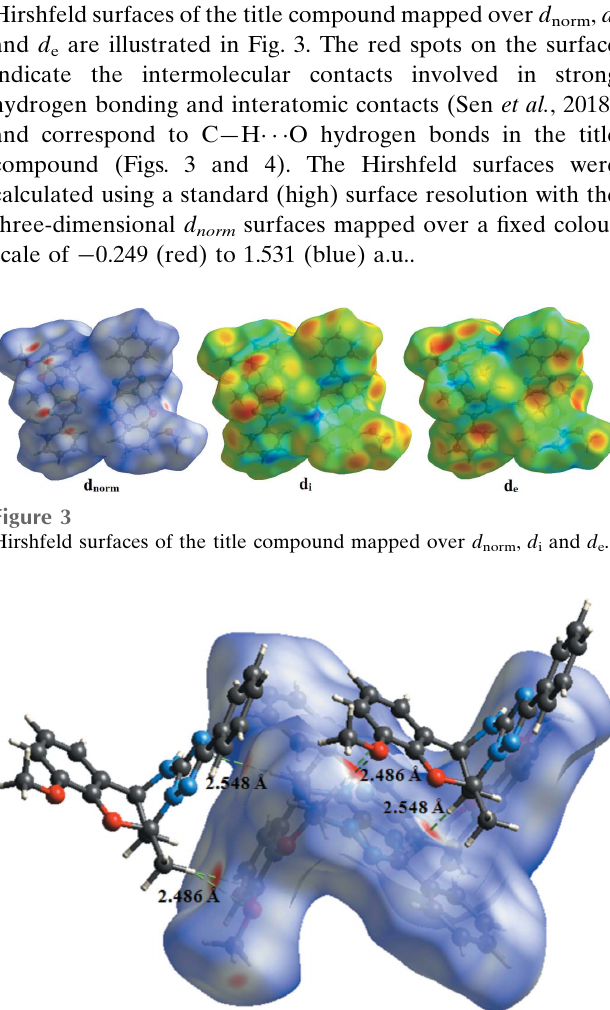
Figure 4 Hirshfeld surface mapped over d norm for visualizing the intermolecular interactions of the title